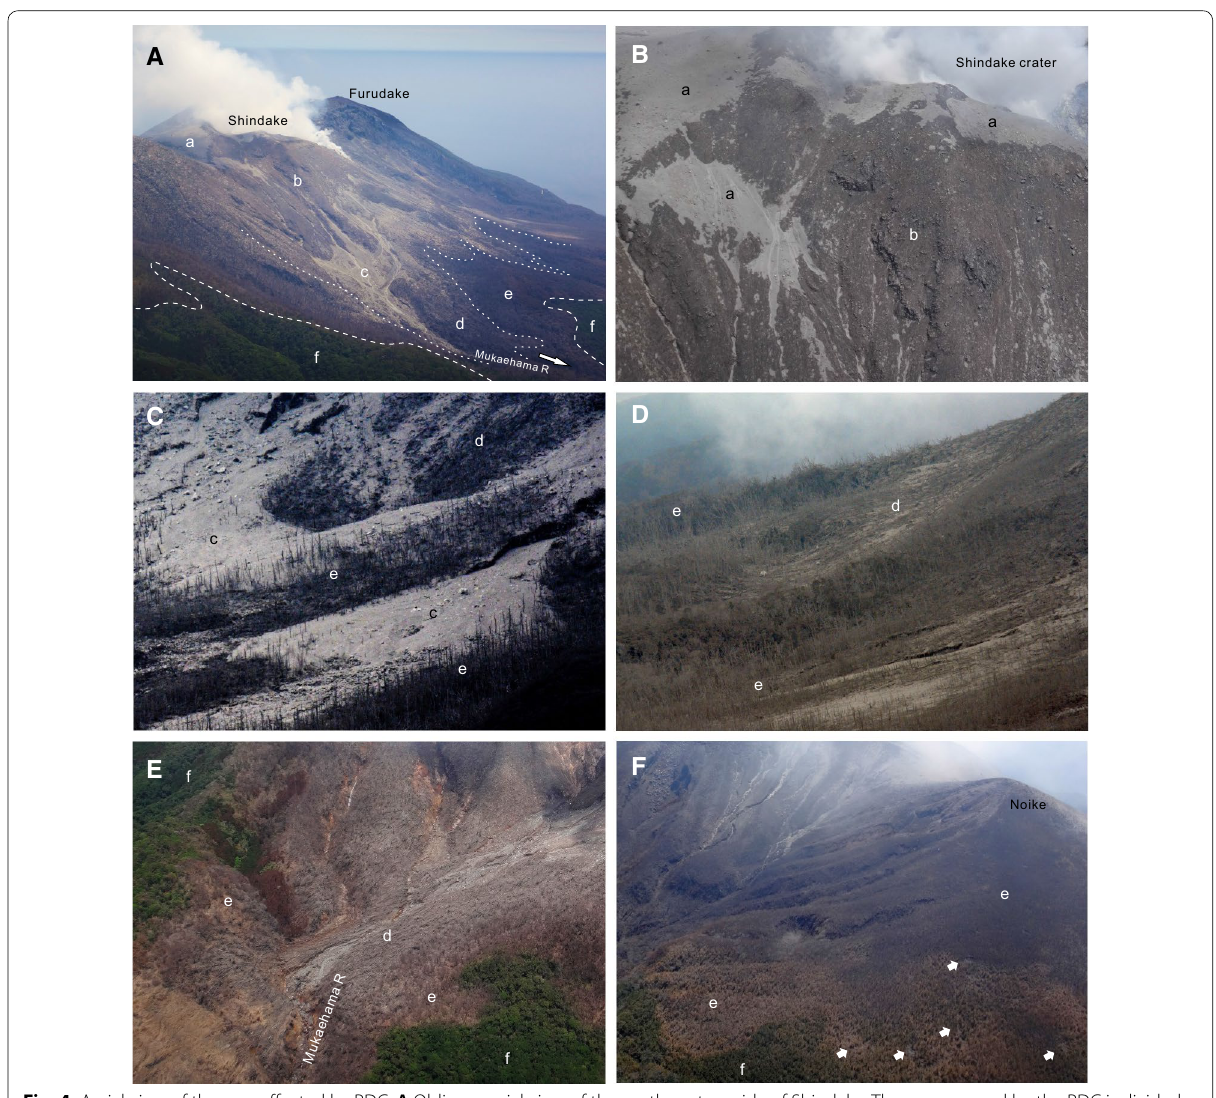
Fig. 4 Aerial view of the area affected by PDC. A Oblique aerial view of the northwestern side of Shindake. The area covered by the PDC is divided into Zone a to Zone e based on the distribution of the deposit and damage to the vegetation. Boundaries between Zones d and e and the outer limit of the Zone e are highlighted with broken lines. Zone f was not covered by the PDC. B Close-up view of the upper northwestern slope of Shindake taken on July 7, showing thick and coarse pyroclastic deposit including large block in Zone a and exposed basement rocks in Zone b. All the vegetations were removed in Zone b. C Close-up view of the fans of block-and-ash flow deposit at the southwestern flank of Shindake. D Trees swept by PDC in Zone d in the western flank of Shindake. Trees in Zone e were still standing but most of the leaves and blanches were lost. E Close-up view of the Mukaehama River showing the change of damage from Zone d (fallen trees)–Zone e (damaged vegetation)–Zone f (green vegetation). F Northeastern margin of the PDC. Discolored vegetations in Zone e and green vegetations in Zone f are shown. Arrows indicate major impact craters. The photographs A and E were taken on July 7; B and F are taken on June 1, 2015, by R. Kazahaya. C and D were taken on May 30, 2015, by N.